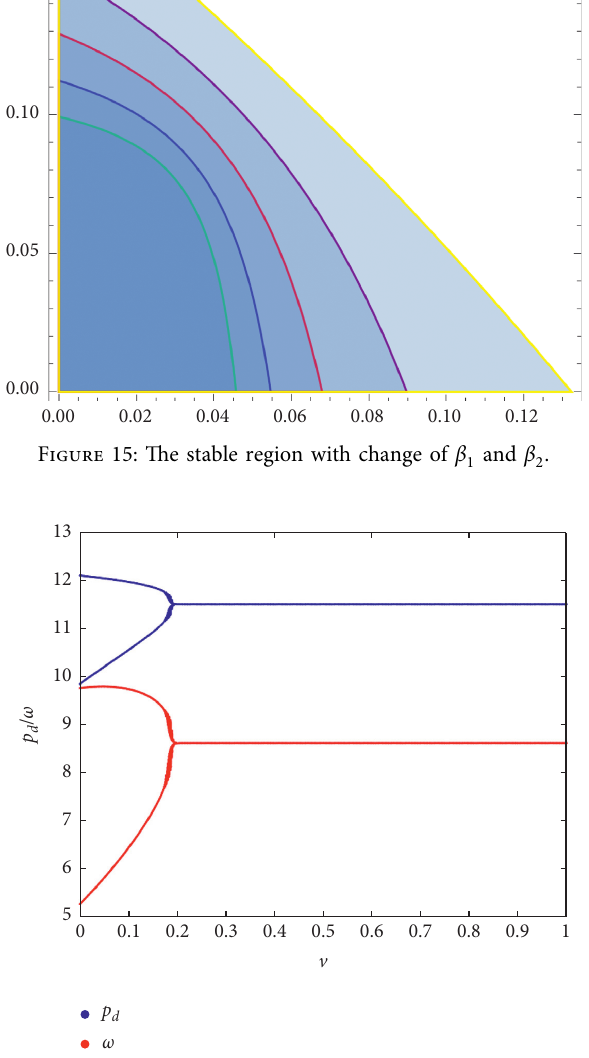
Figure 16: Bifurcation diagram with v